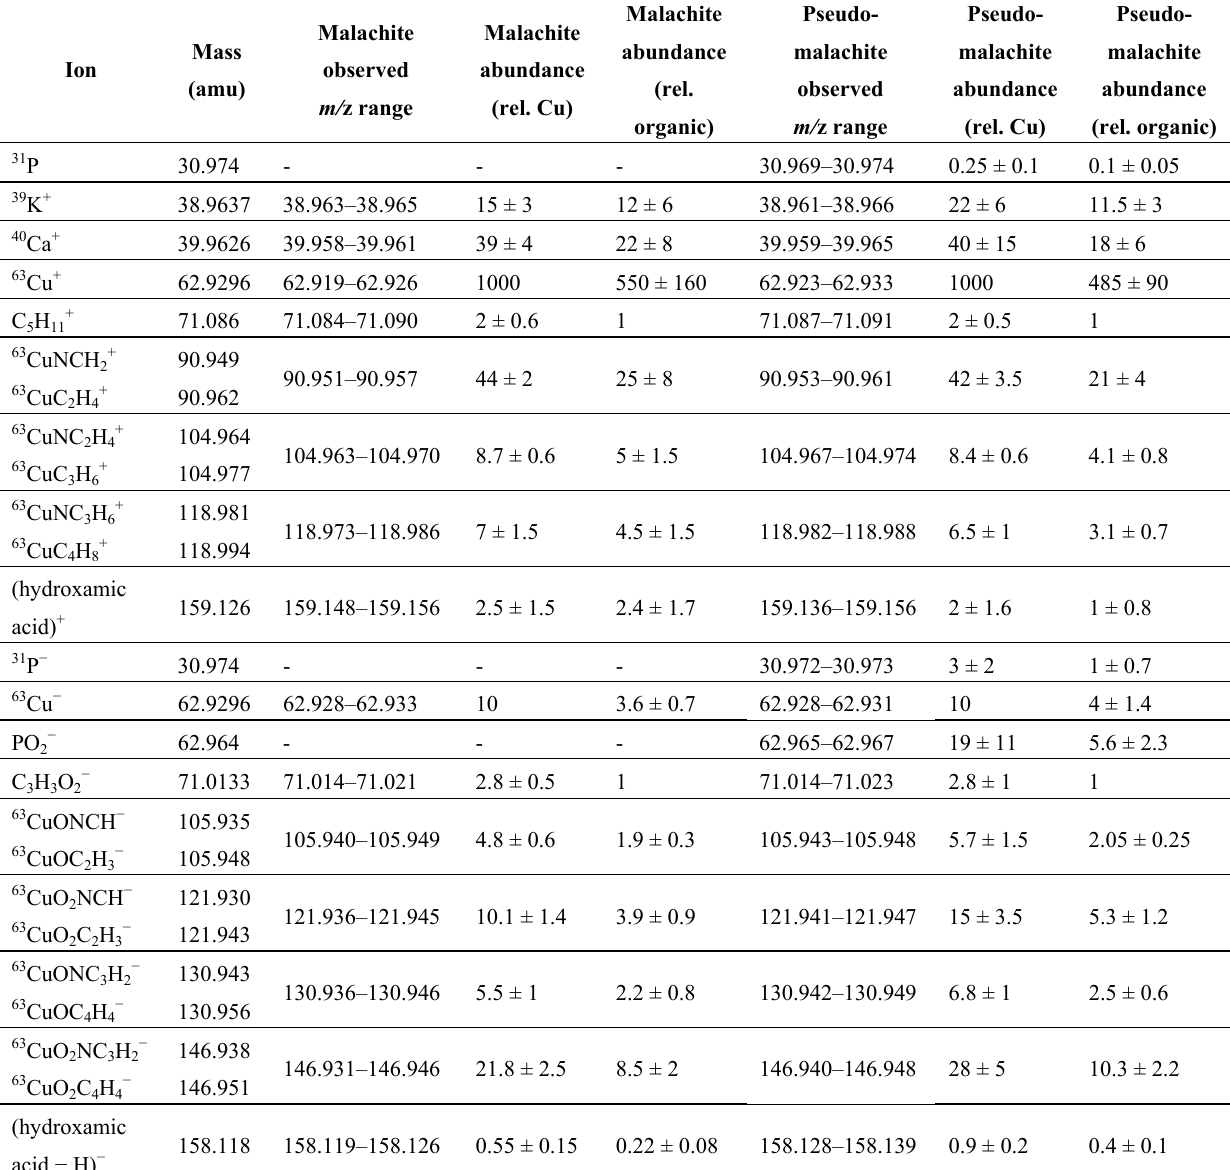
Table 4. Diagnostic ions and their observed m/z and relative abundance ranges for conditioned malachite and pseudomalachite